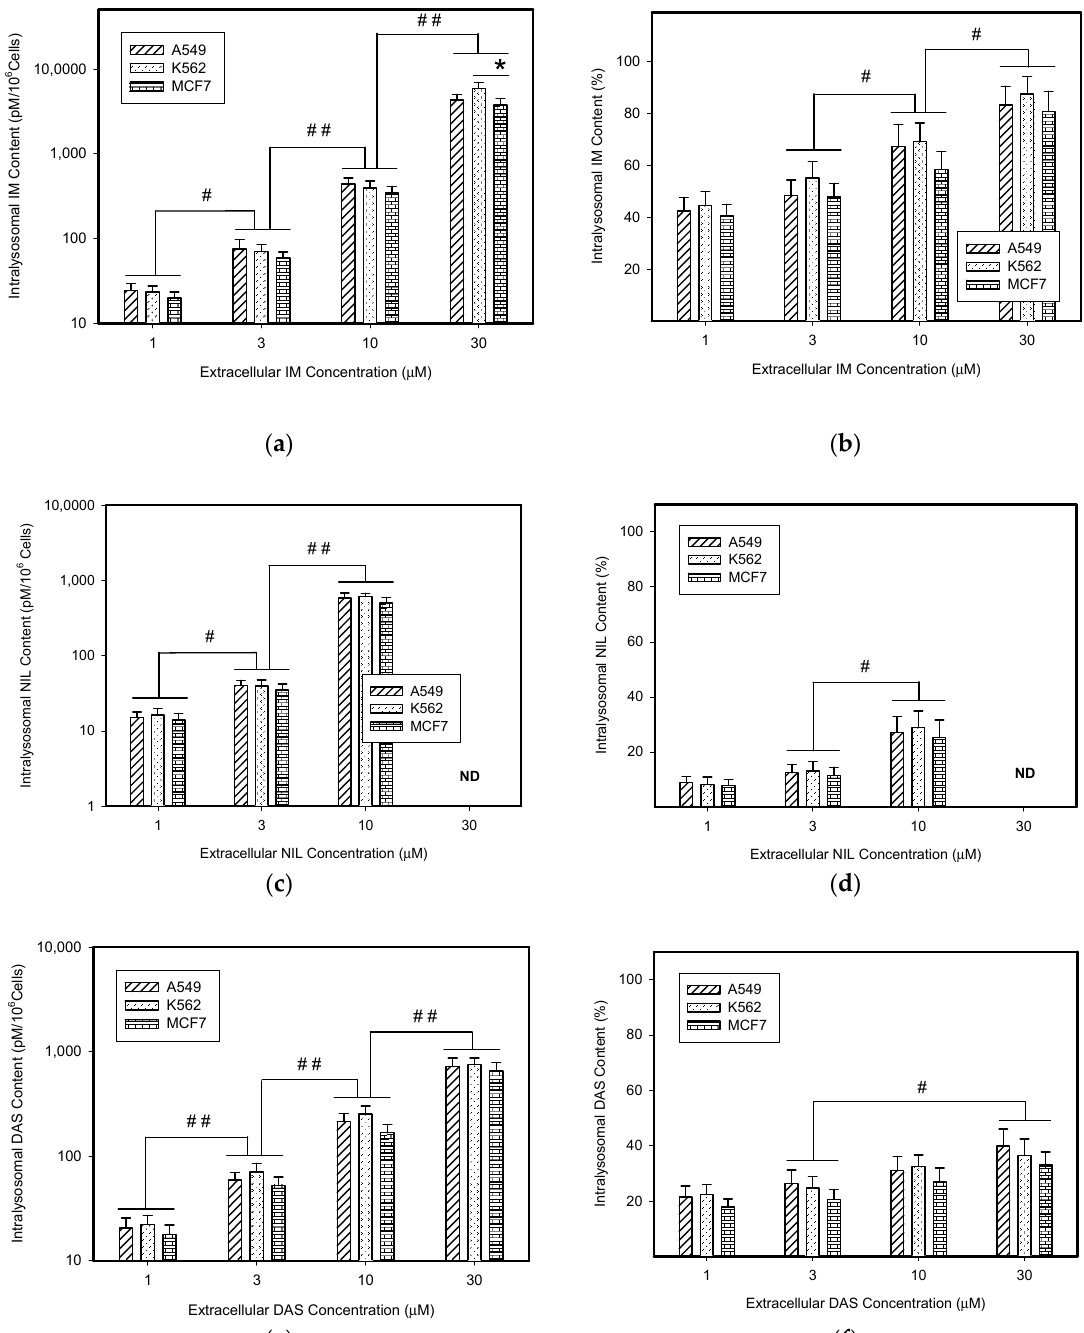
Figure 2. Lysosomal sequestration of TKIs. ( a ) Absolute accumulation of IM in lysosomes of cancer cells. ( b ) Relative accumulation of IM in lysosomes of cancer cells. ( c ) Absolute accumulation of NIL in lysosomes of cancer cells. ( d ) Relative accumulation of NIL in lysosomes of cancer cells. ND—not determined (due to limited NIL solubility). ( e ) Absolute accumulation of DAS in lysosomes of cancer cells. ( f ) Relative accumulation of DAS in lysosomes of cancer cells. Columns represent the means and standard deviations of four independent experiments. * denotes a significant change in the intralysosomal IM content ( p < 0.05) between the indicated cell lines. # denotes significant change in the intralysosomal content of the appropriate TKI ( p < 0.05) between the groups indicated. ## denotes a very significant change in the intralysosomal content of the appropriate TKI ( p < 0.01) between the groups indicated.